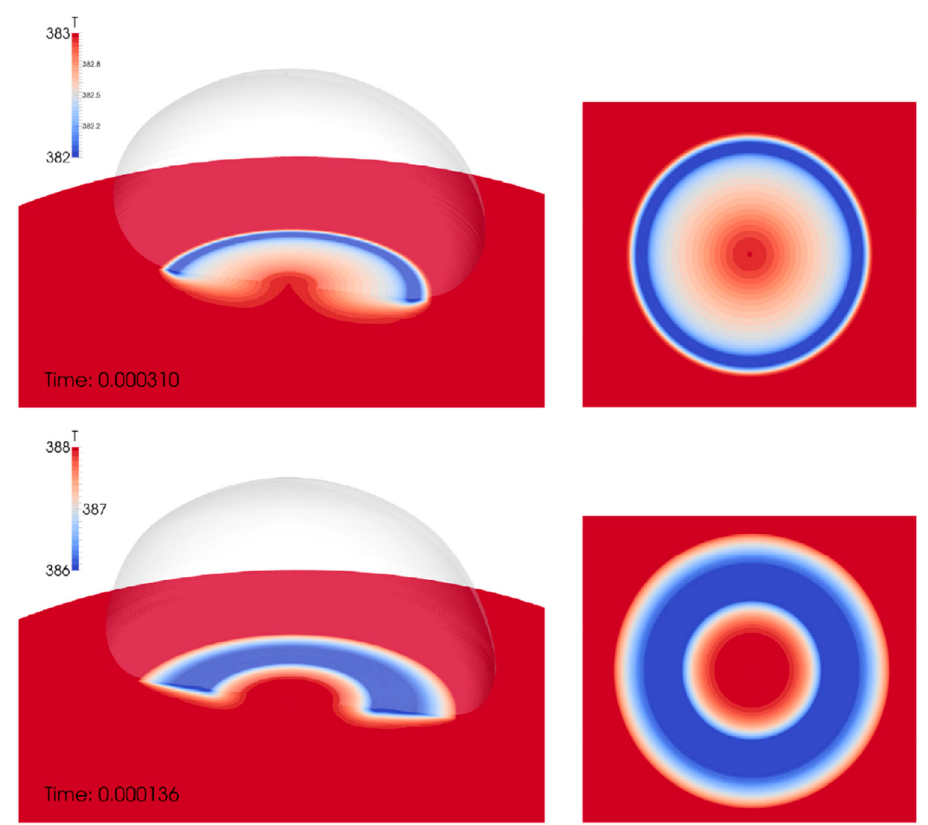
Figure 10. Microlayer formation and depletion beneath a bubble growing at a heated wall, a typical example of the importance of variables associated with the solid surface. From Hänsch et al. [67,73].